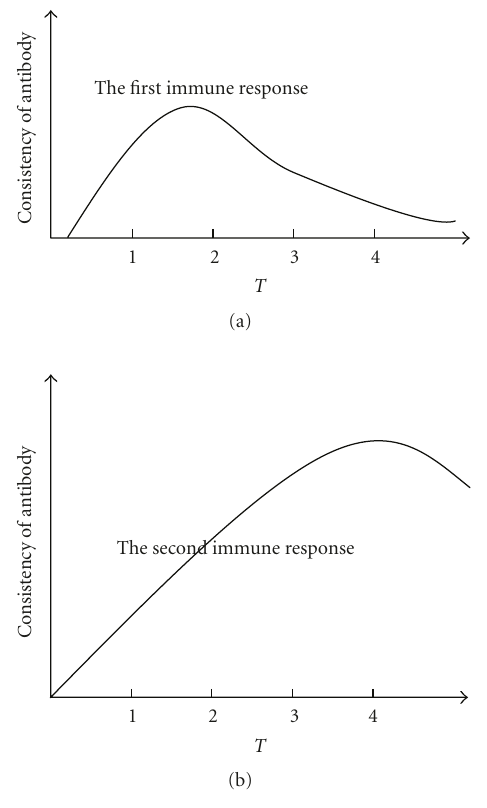
Figure 1: Immune response